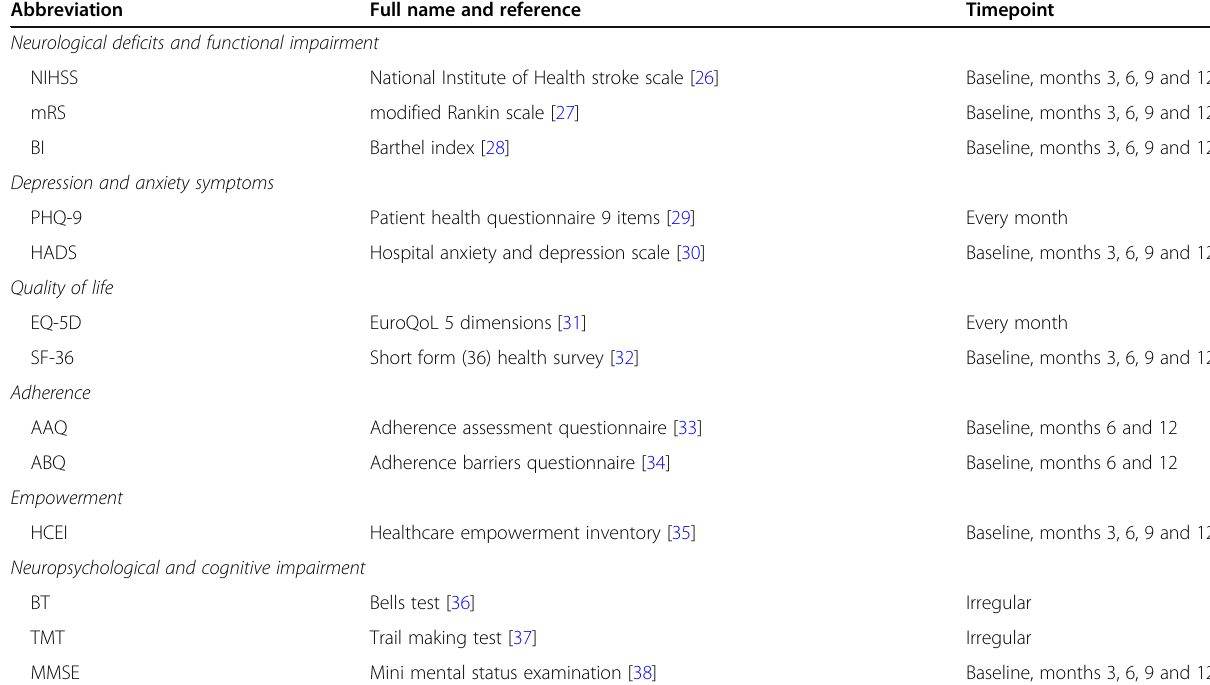
Table 1 Overview of clinical and psychometric